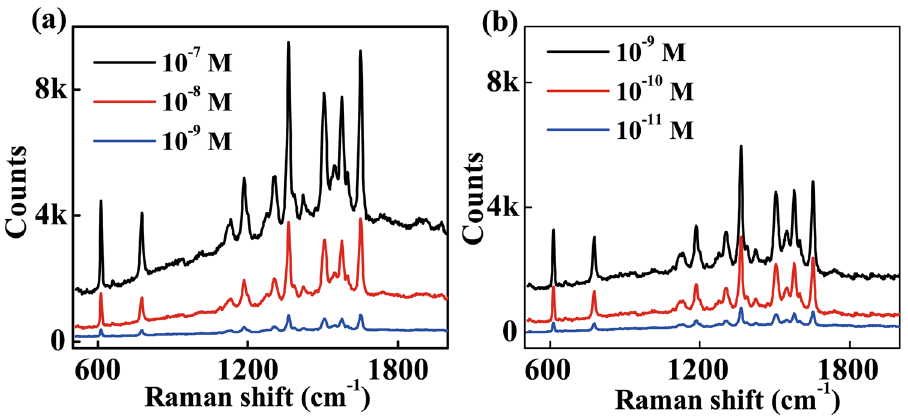
Figure 6. ( a ) SERS spectra of R6G at different concentrations for original GNS4 probe. ( b ) SERS spectra of R6G at different concentrations for GNS4 probe with 3.5 minutes acetone treatment